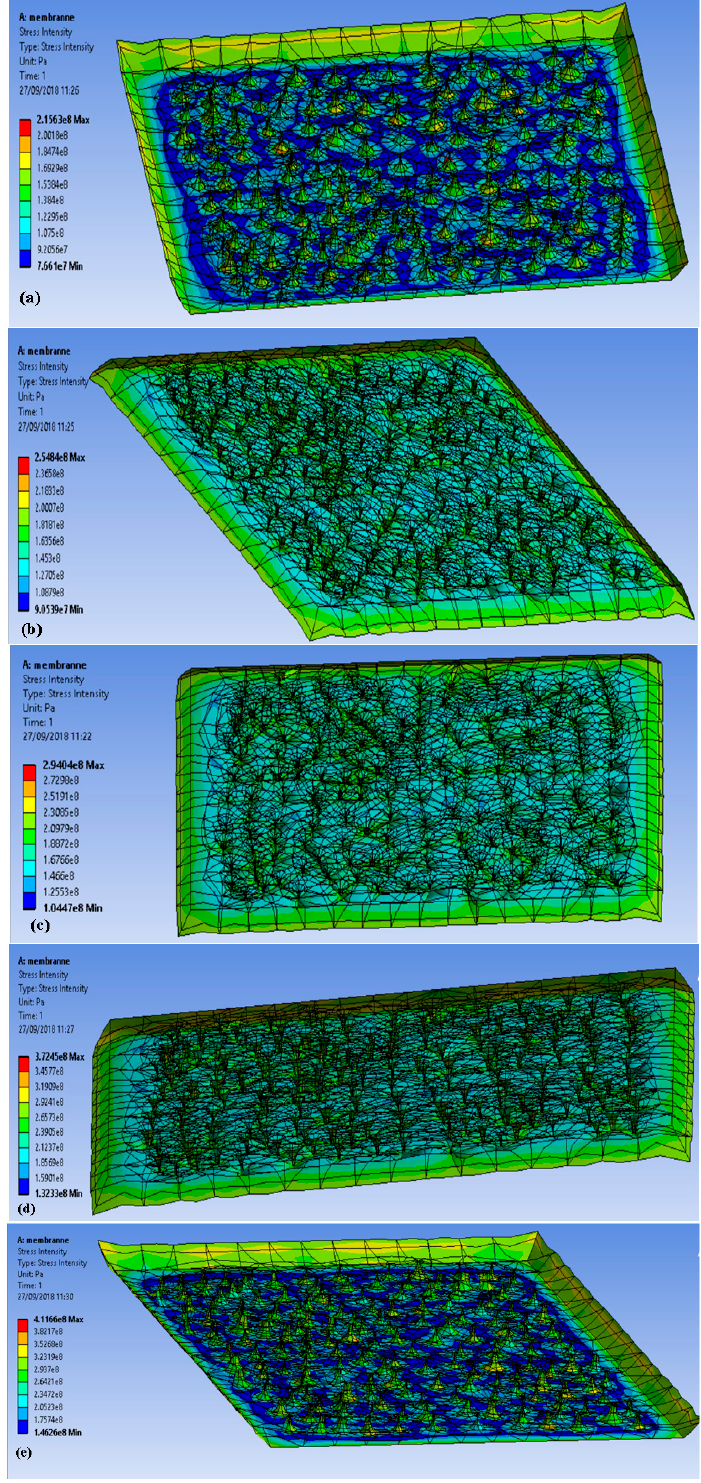
Figure 5. The stress intensity legend for the forces of ( a )1.0 µN; ( b ) 1.9 µN; ( c ) 2.7 µN; ( d ) 3.3 µN; and ( e ) 3.8 µN.